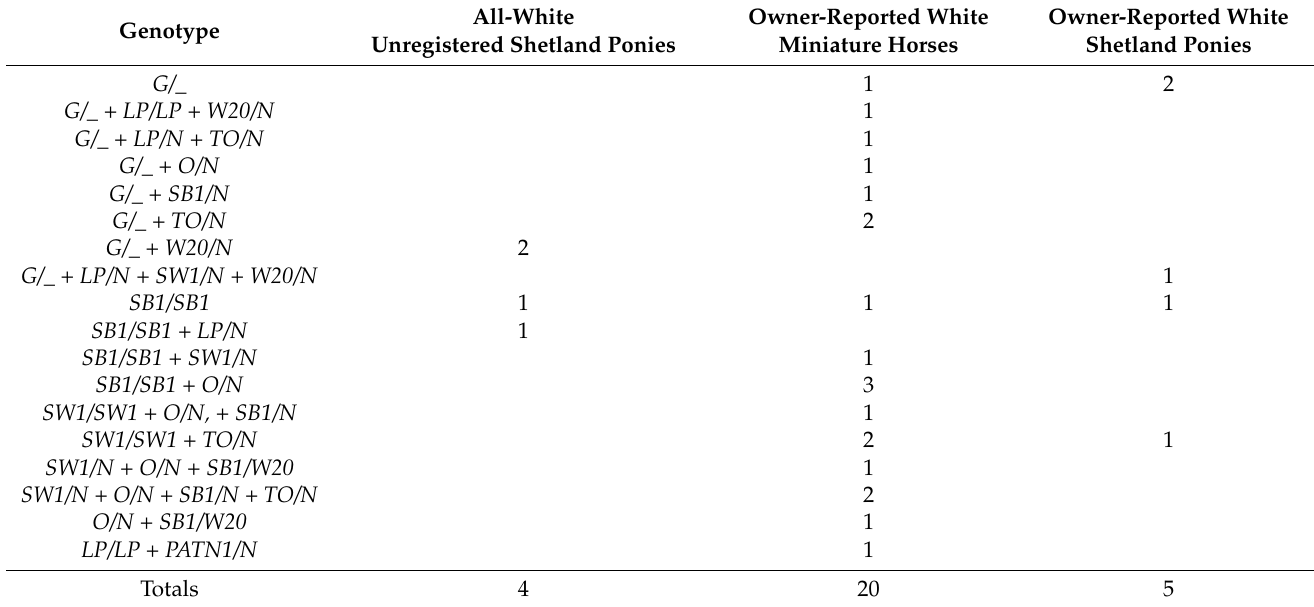
Table 2. Genotypes detected during routine testing contributing to white coat pattern phenotypes in Miniature Horses and Shetland ponies.